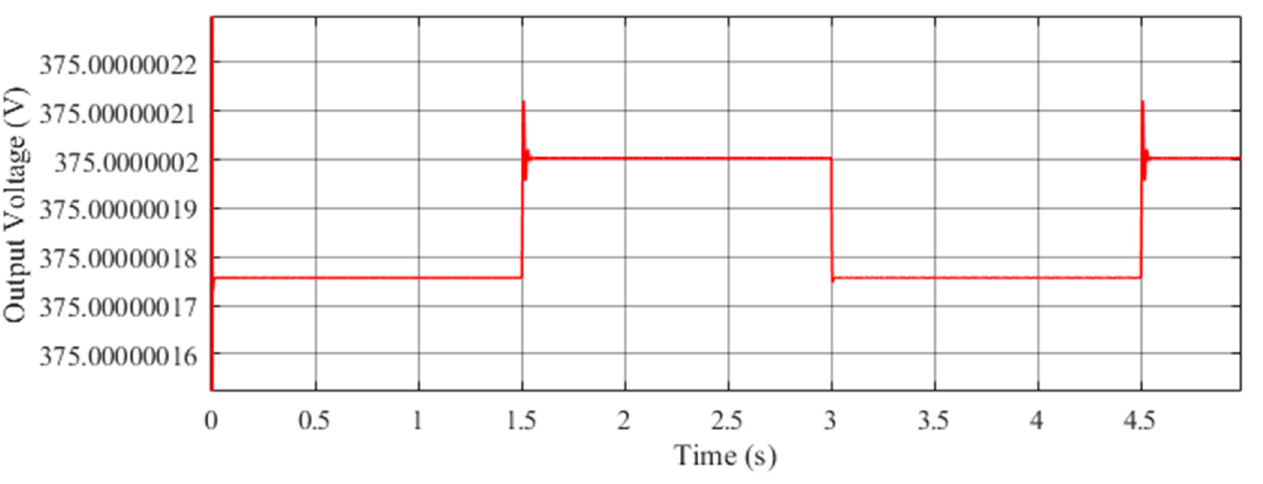
Figure 20. Frequency control during solar radiations variations. 4.5. Case-5. Validations of Proposed Controller with Battrey Energy Storage System. In order to overcome the influence of irradiation fluctuation, a battery energy storage system is applied in the system to suppress the fluctuation of output Power of PV source. Case 1: Change in PV Power Due to Solar Irradiations In this case study the PV system is producing large power than the load demand for time instant up to 1.5 s. In this time period the PV system is working at standard solar irradiation, i.e., 1000 W/m (cid:2870) . Thus the PV system will provide extra power in this time period which is show in Figure 21. This extra power form PV source will be stored in to battery energy storage system after satisfying the load demand and it is presented in Fig- ure 22. The PCC bus voltage is given in Figure 23.